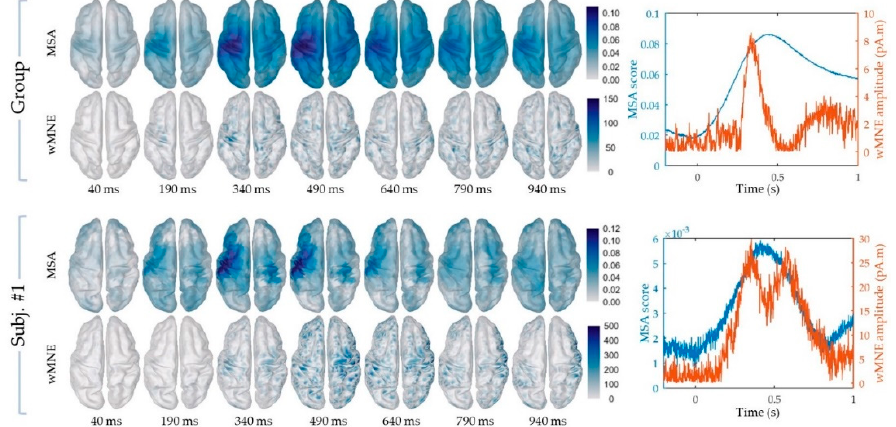
Figure 4. “FlexElbow” experiment: (Left) Cortical mapping of the absolute values calculated using the MSA (upper rows) and the wMNE method (lower rows), based on the visual trigger. (Right) Time course of the mean absolute value in the Lmot region using the MSA (blue curve) and the wMNE method (orange curve). The results shown correspond to the group-level calculations (upper frame) and to a specific subject for illustration (subj. #1).